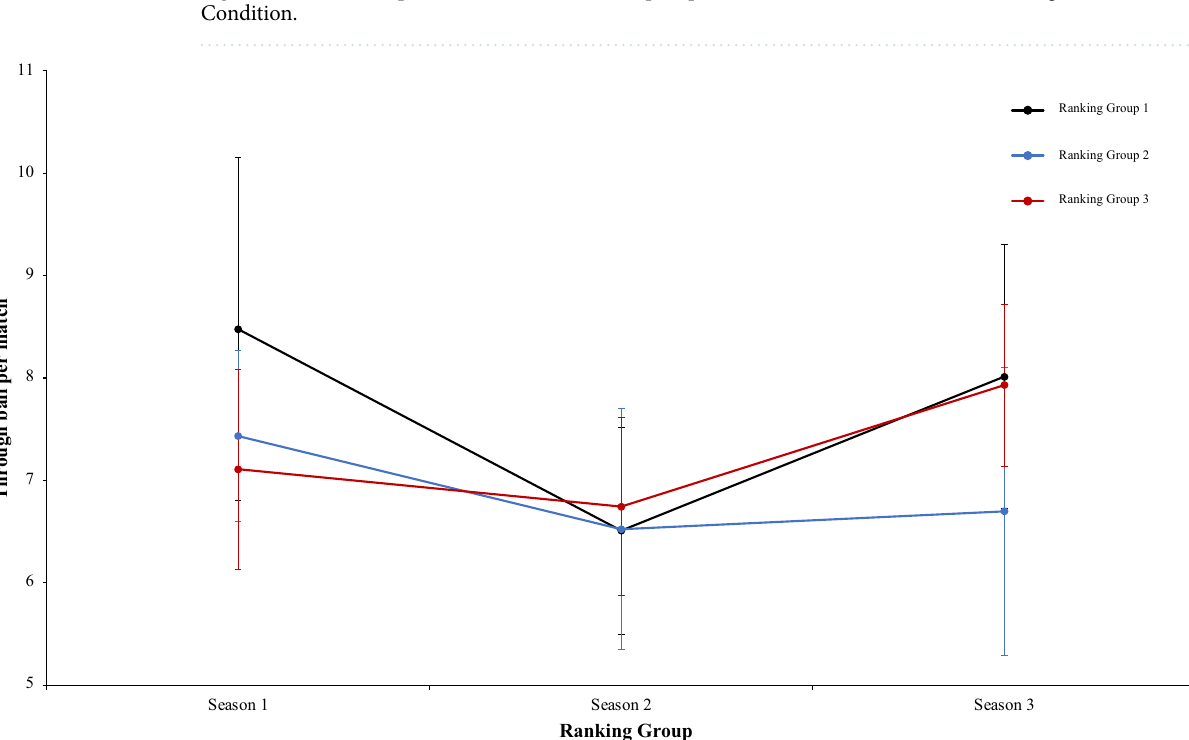
Figure 12. Technical performance. Mean throught ball per match (± SE) as a funtion of Ranking and Season